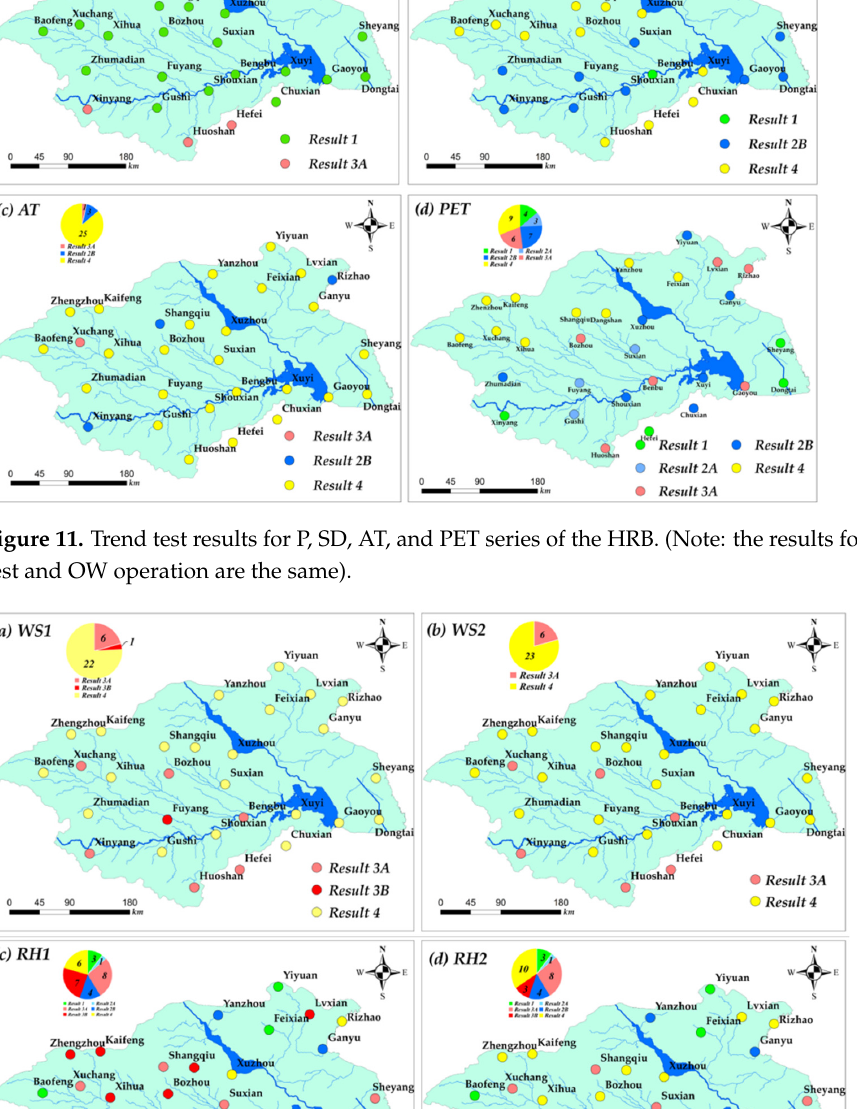
Table 4. Trend slopes for the annual SD, AT, and PET series in the HRB derived by the trend tests based on the MMK test and OW operation at the 5% significance level.